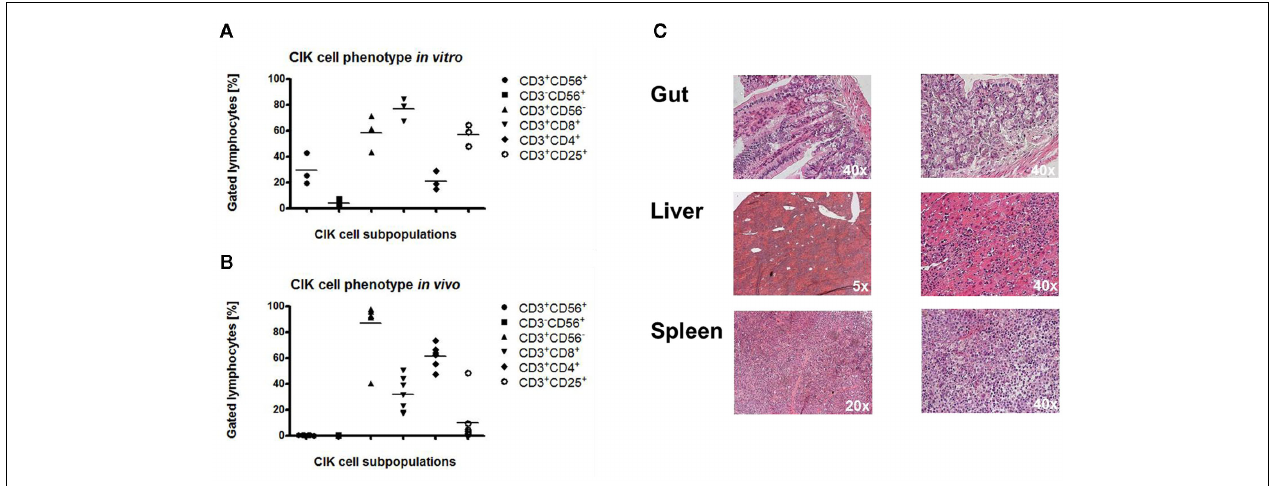
predominantly a CD3 + CD56 − T cell phenotype (B) . Most of theseT cells were CD4 + rather than CD8 + (B) . Histological analysis from one representative CIK cell treated mouse with the best CIK cell engraftment (mouse no. 7, Figures 5B,E , 1 × 10 4 THP-1 cells + 2.5 × 10 6 CIK cells) showed no xenogenic GvHD in classical GvHD targeted tissues like gut and liver as well as in spleen, the preferred homing sites of CIK cells (C)